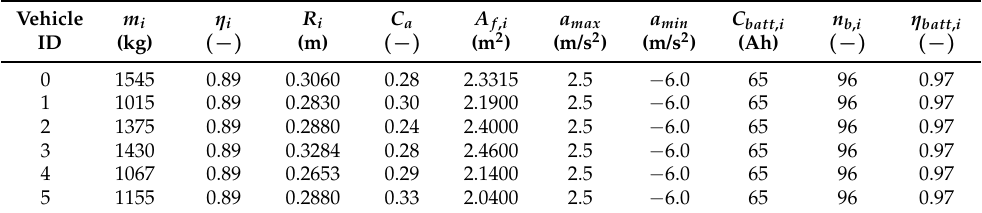
Table 1. Heterogeneous nonlinear vehicles